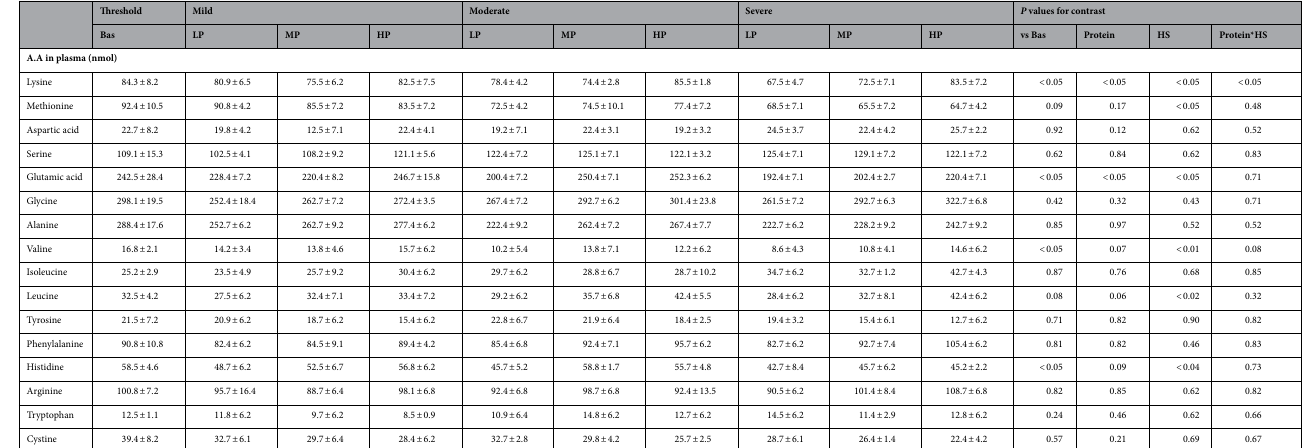
Table 8. Effects of dietary protein levels on blood amino acid profiles in Korean native beef calves under heat stress. vs Bas = Control (with 12.5% dietary protein levels, THI 68 to 70) vs 9 experimental diets (with 3 dietary protein levels, with 3 THI levels). THI = Temperature humidity index. Threshold = THI 70 to 73, Mild = THI 74 to 76, Moderate = THI 81 to 83, Severe = THI 89 to 91. LP = Low protein (12.5%), MP = Medium protein (15%), HP = High protein (17.5%). The data are presented as the means ± standards error (n =